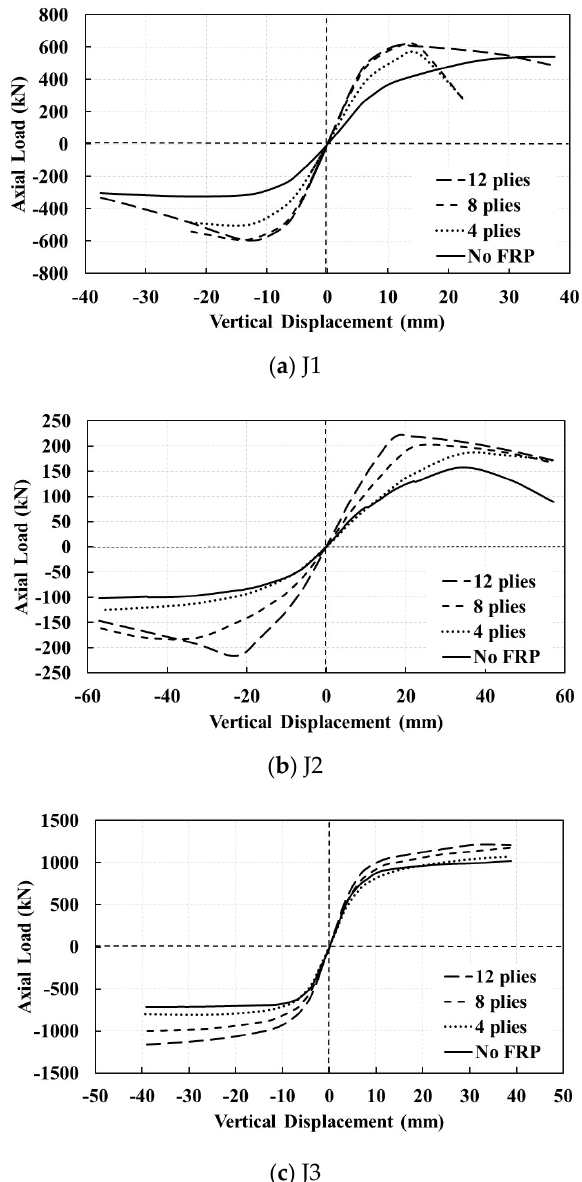
Figure 12. Comparison of the envelope curves of hysteresis load displacement plots with different numbers of FRP layers for both chord and brace: ( a ) J1, ( b ) J2, and ( c ) J3 model.